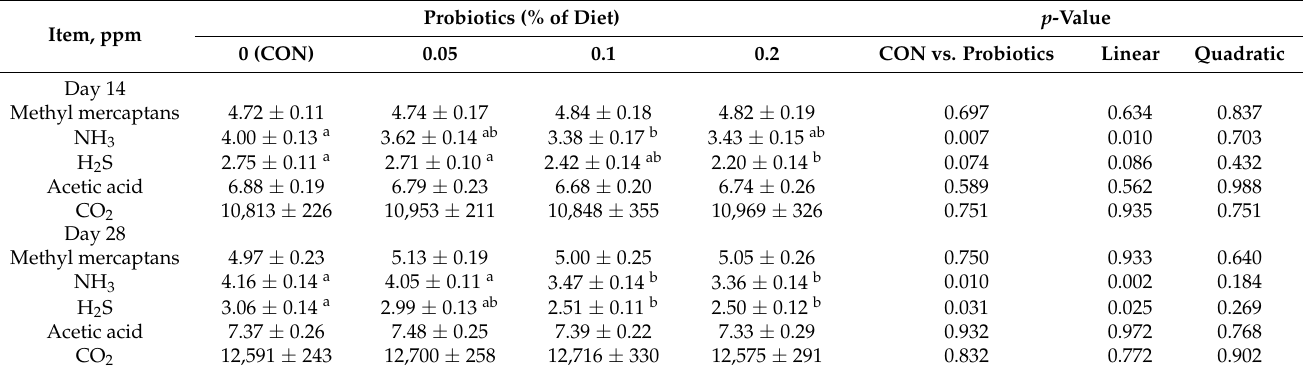
Table 9. Effects of dietary complex probiotic supplementation on fecal gas emissions in growing